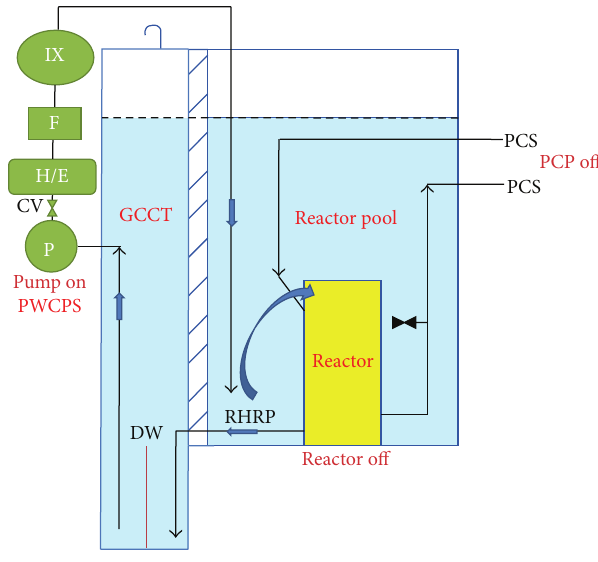
Figure 8: Reactor normal shutdown.